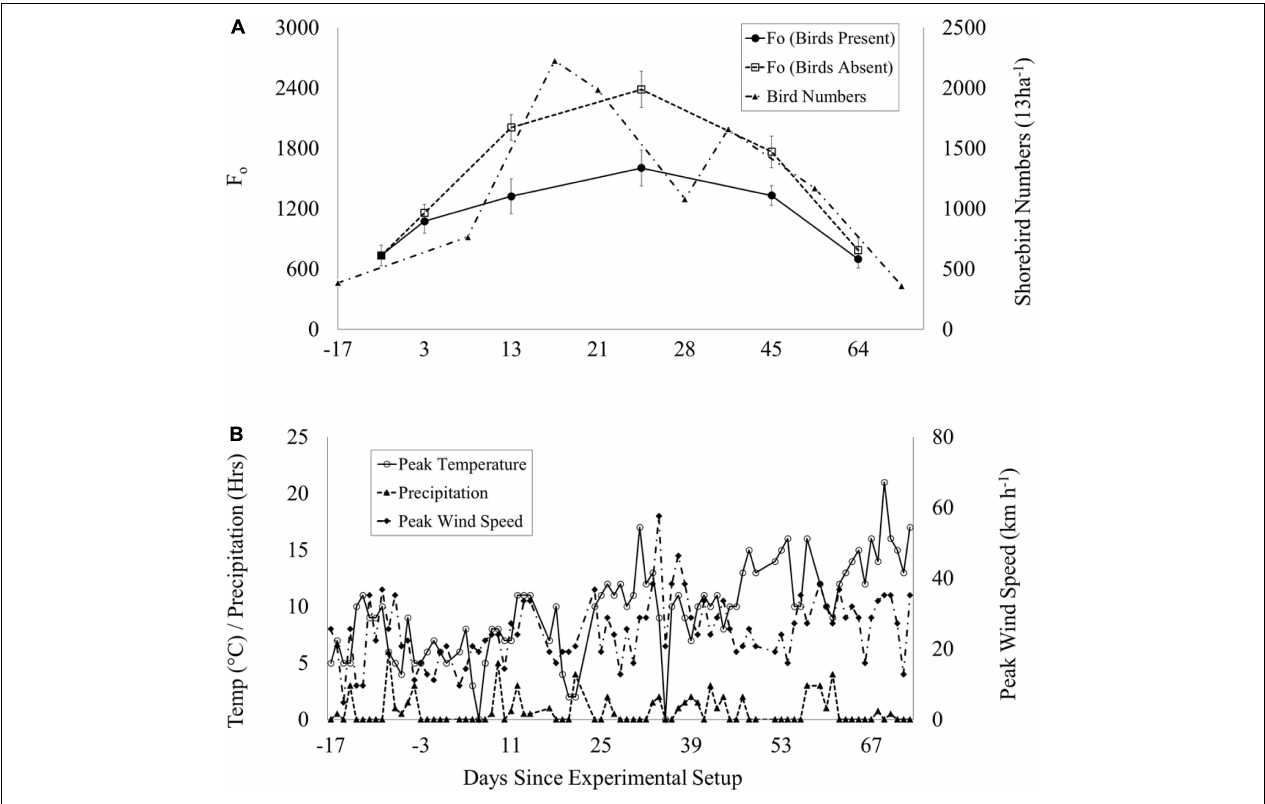
FIGURE 2 | Time series during the experimental period (03 Jan – 03 April 2017): (A) Mean F o ( ± SE, n = 50) in shorebird presence (solid line, filled circles)/absence (dotted line, unfilled squares) plots and total peak shorebird count (multi-dash line, filled triangles). Dip in numbers on day 28 coincides with disturbance of flocks by marsh harrier. (B) Weather data per day: peak temperature ( ◦ C): solid line with unfilled circles, peak wind speed (km h − 1 ): multi-dash with filled diamonds and precipitation (hours): dash with filled